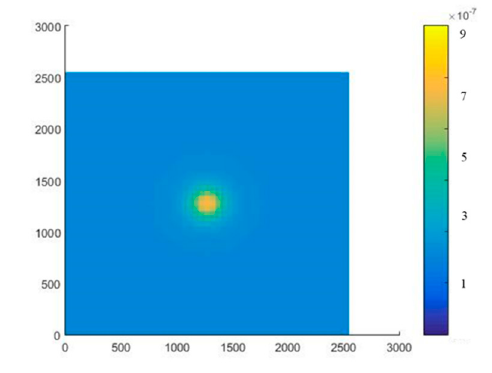
Figure 6. Comparison of deposited sulfur saturation across the simulated reservoir.